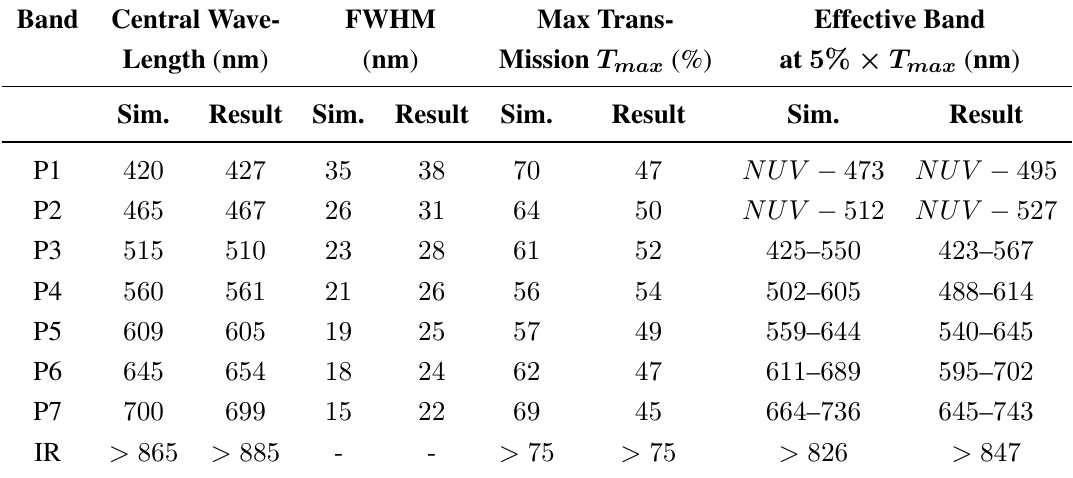
Table 2. Optical specifications of filter bands, theoretical simulation (Sim.) and practical